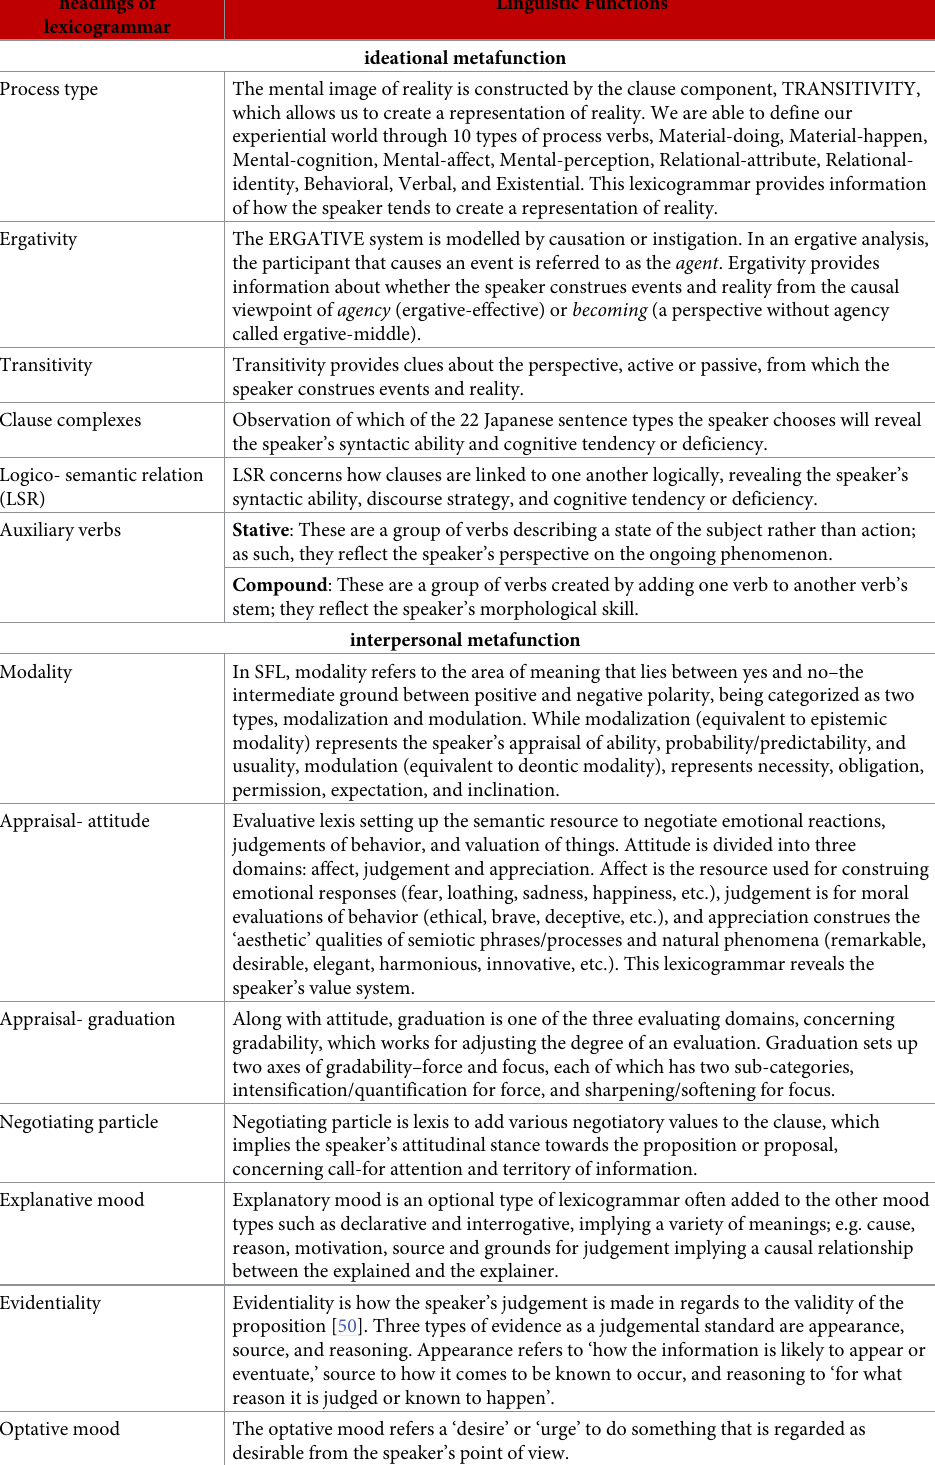
Table 4. Linguistic functions of annotated